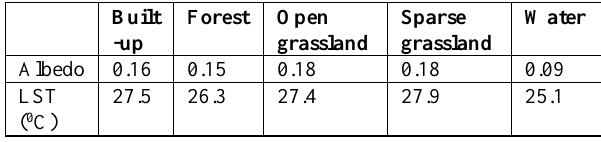
Table 7: Mean albedo and LST for each land cover